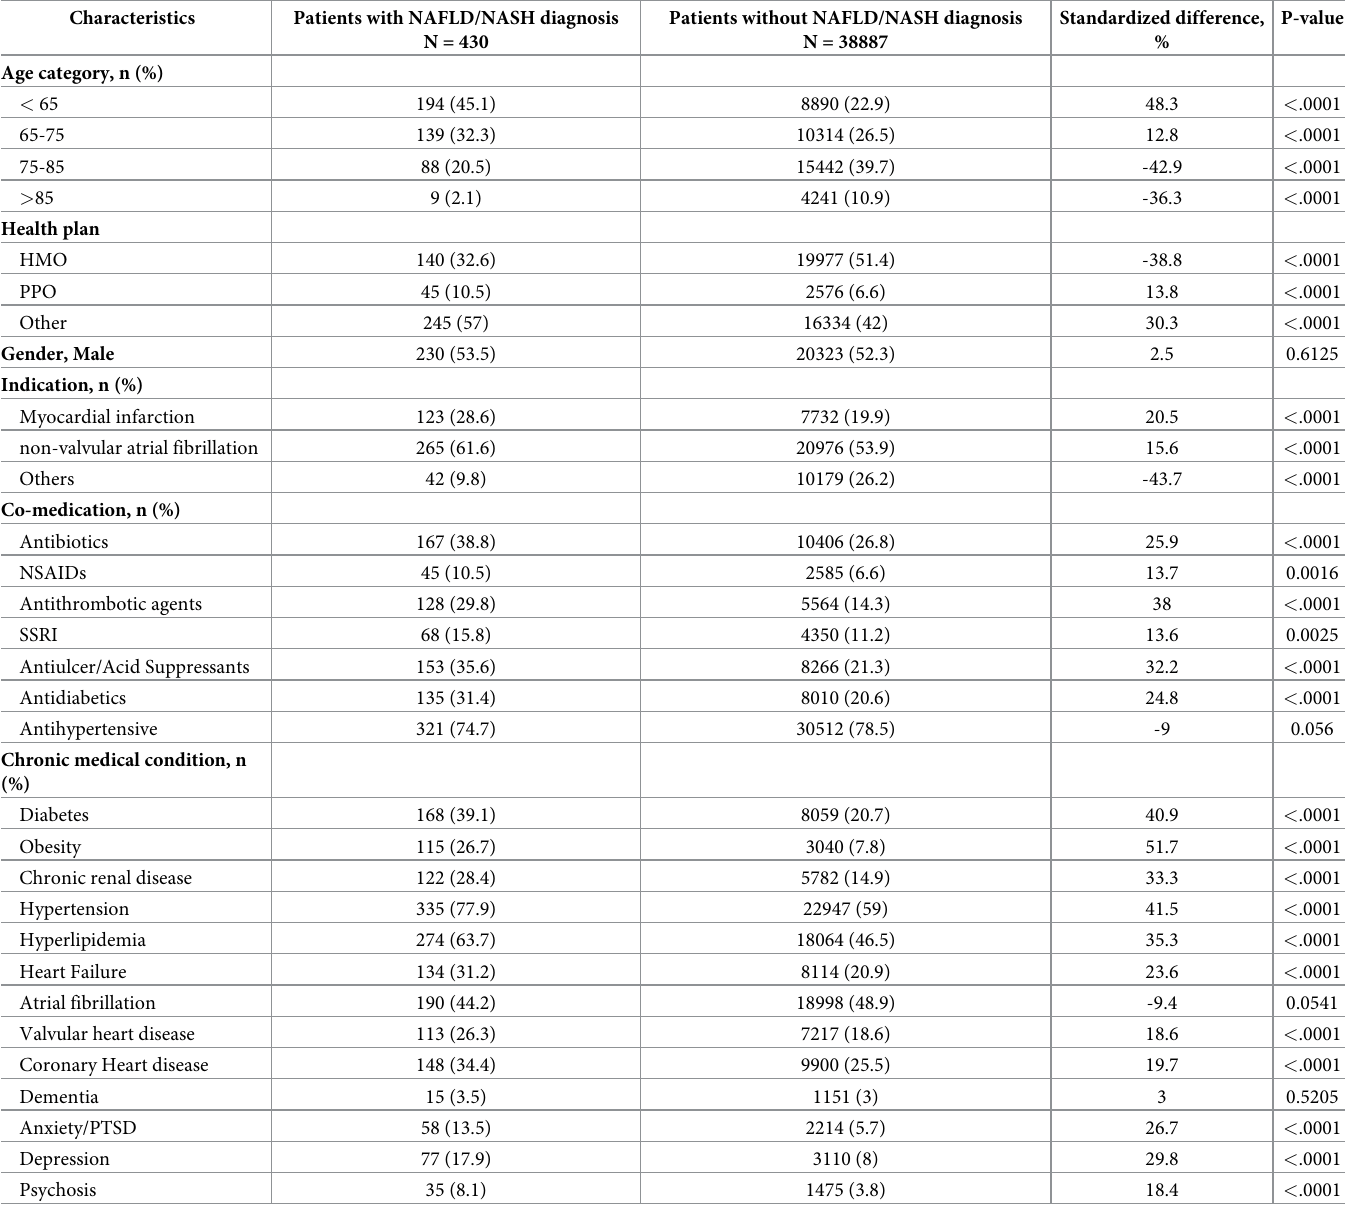
Table 1. Demographic and clinical characteristics of study population selected from health plan data between 2010 – 2015.